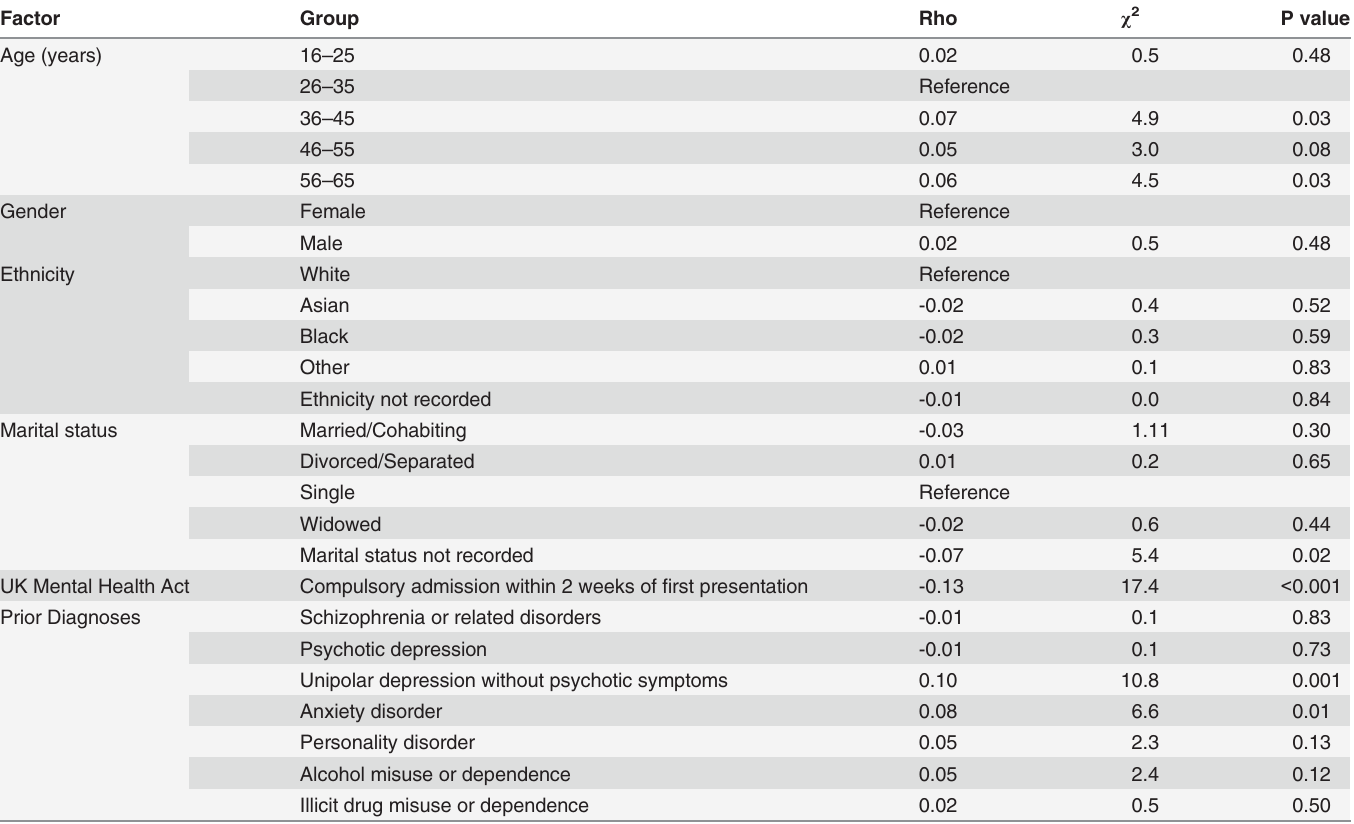
Table 6. Test of proportionality of hazards on Schoenfeld residuals for treatment